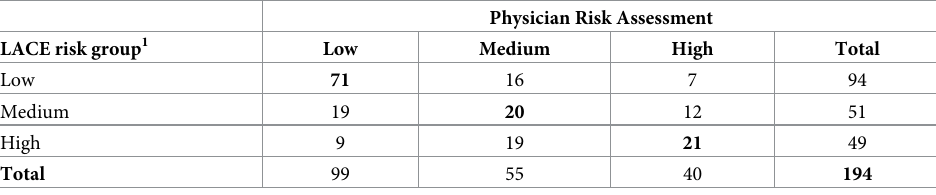
Table 3. Agreement between physician risk assessment and LACE